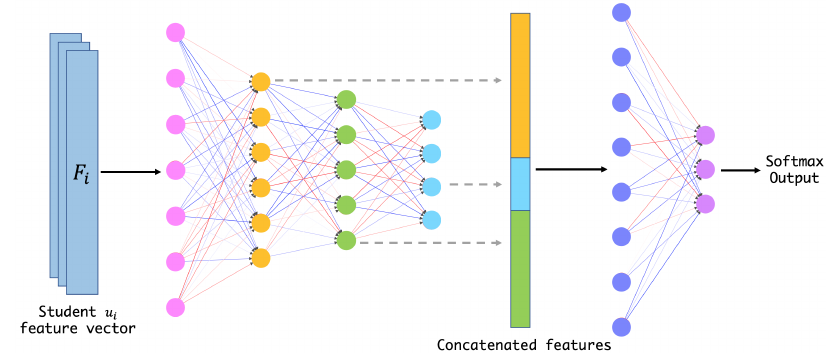
Figure 5. The architecture of the proposed Artificial Neural Network (ANN)